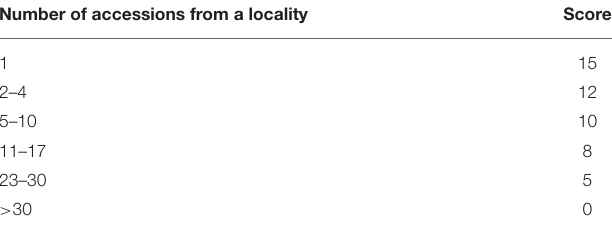
TABLE 3 | Score table for number of locality areas. Number of accessions from a